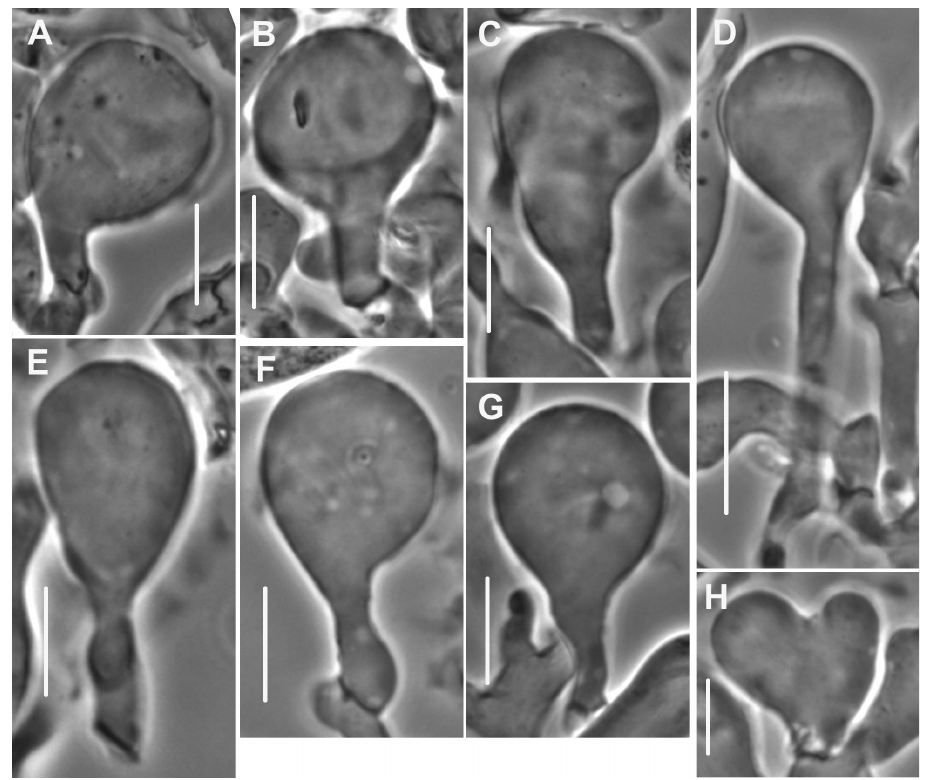
Figure 4. Mycetinis alliaceus . Pileipellis elements. Standard bars = 10 µm. TFB 11451